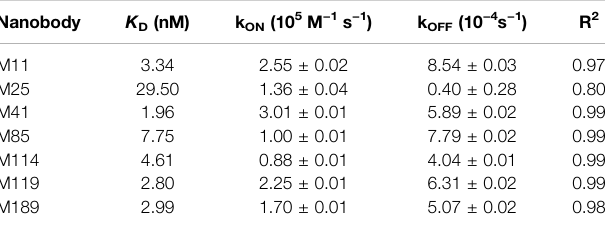
TABLE 1| Summaryofaf fi nities(K D ),association(k ON ) anddissociationconstants (k OFF ) and the coef fi cient of determination (R 2 ) determined for Miro1-Nbs by BLI.